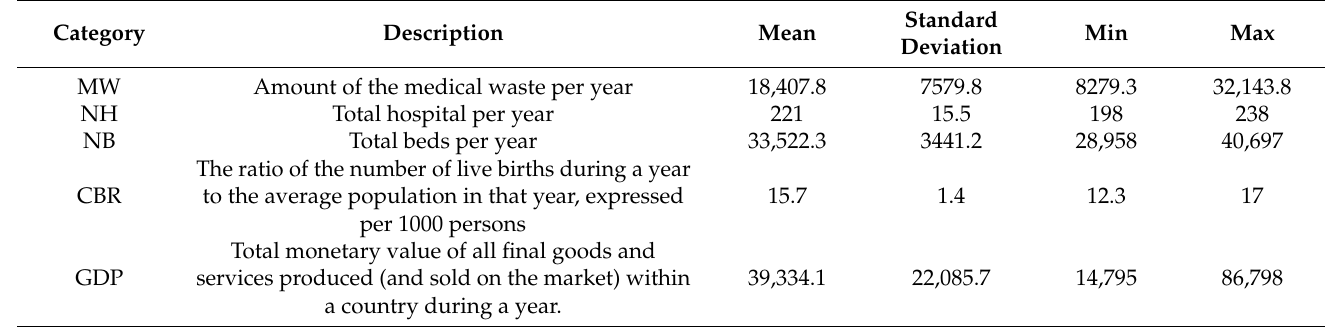
Table 2. Statistics that are descriptive of both the input and the output